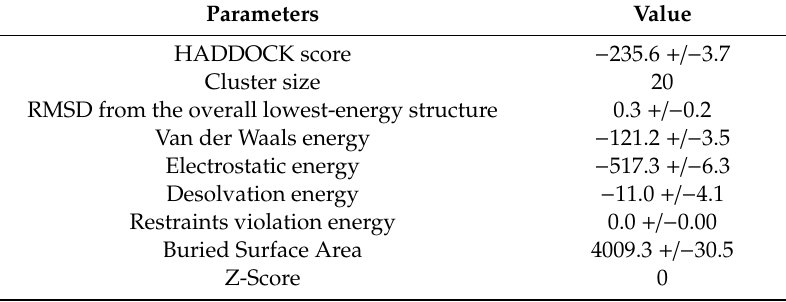
Table 2. Table showing statistics of top vaccine-TLR4 docked cluster. Statistics of top ranked vaccine-TLR4 cluster are shown. Lower HADDOCK score signifies strong interaction between